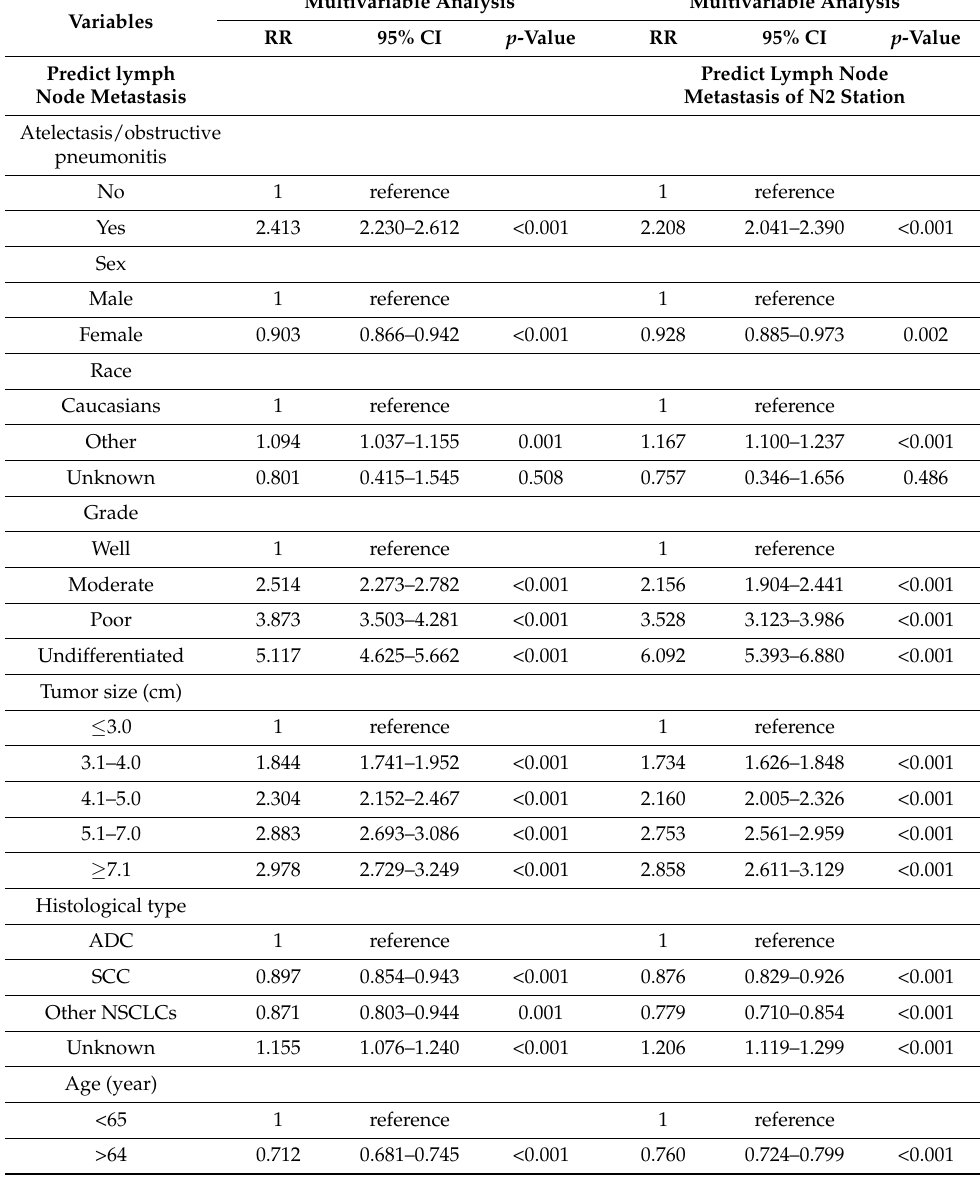
Table 2. Multivariable Logistic regression for a risk ratio of lymph node metastasis. Multivariable Analysis Multivariable Variables